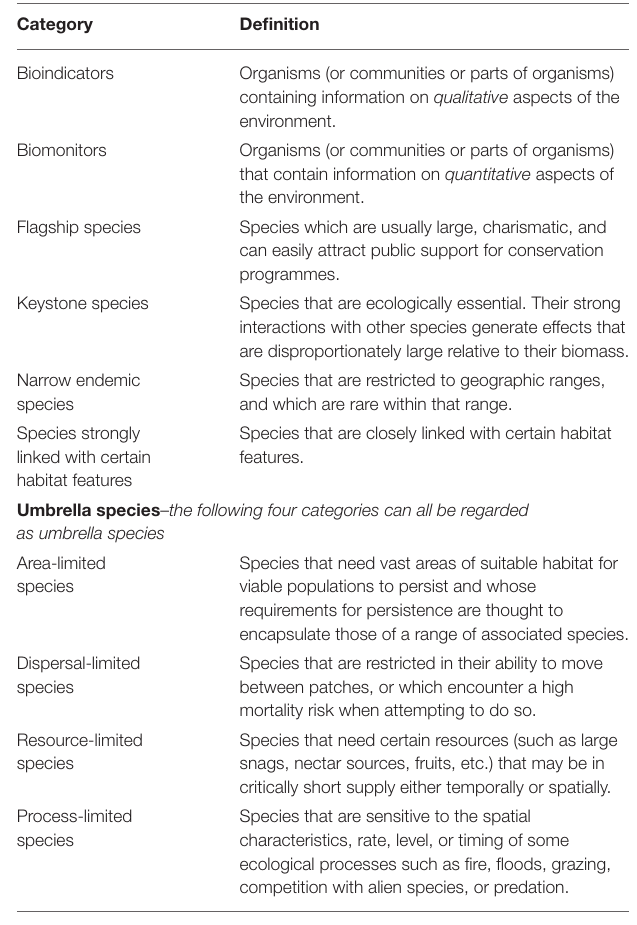
TABLE 1 | Categories of potential indicator species (Lambeck, 1997; Noss, 1999; Carignan and Villard, 2002; Markert et al.,